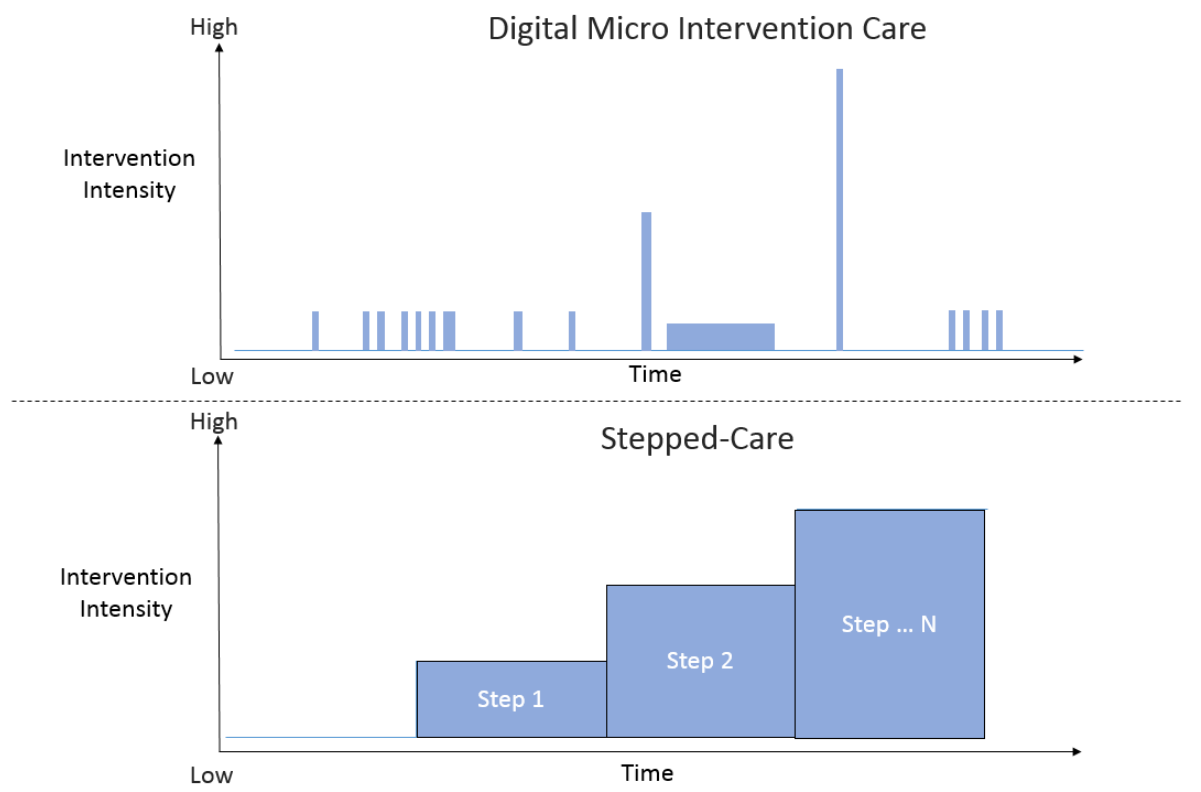
Figure 5. Illustrations of stepped care and digital micro intervention care